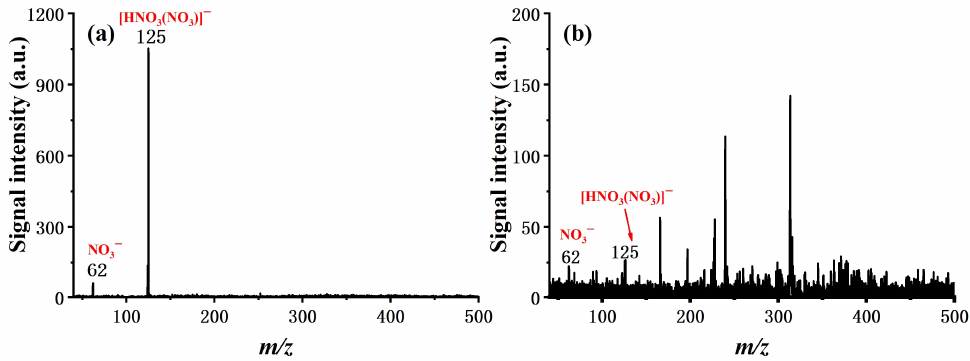
Figure 1. Mass spectra of background in the case of discharge gas flow ( a ) in forward direction and ( b ) in counter direction. The sample flow was set to 0 mL/min in either